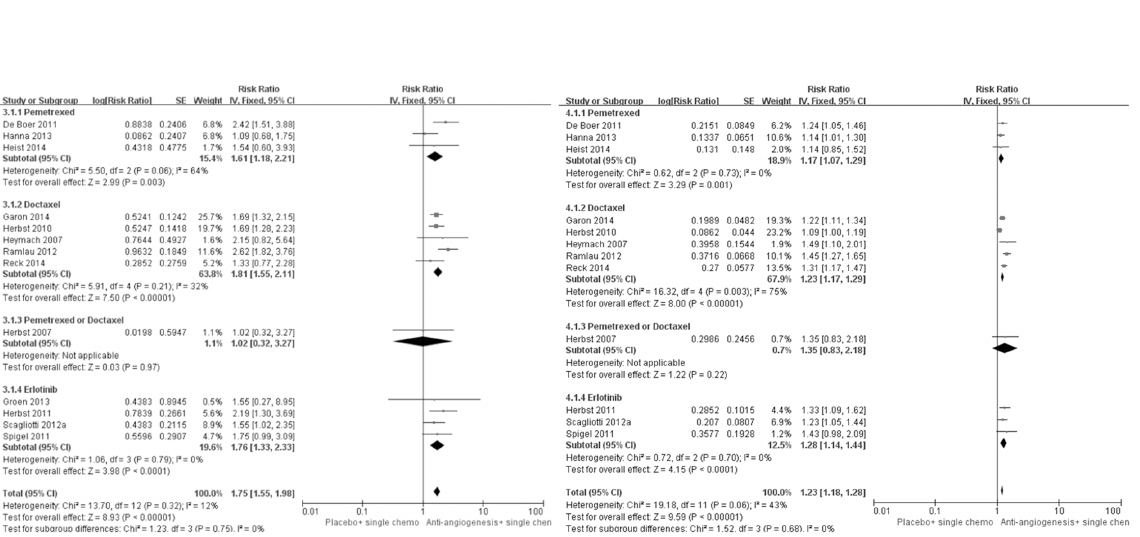
Fig 4. Forest plot and pooled RR & 95%CI for ORR (left) and DCR (right): Antiangiogenic agents plus single agent chemotherapy versus standard second-line chemotherapy.